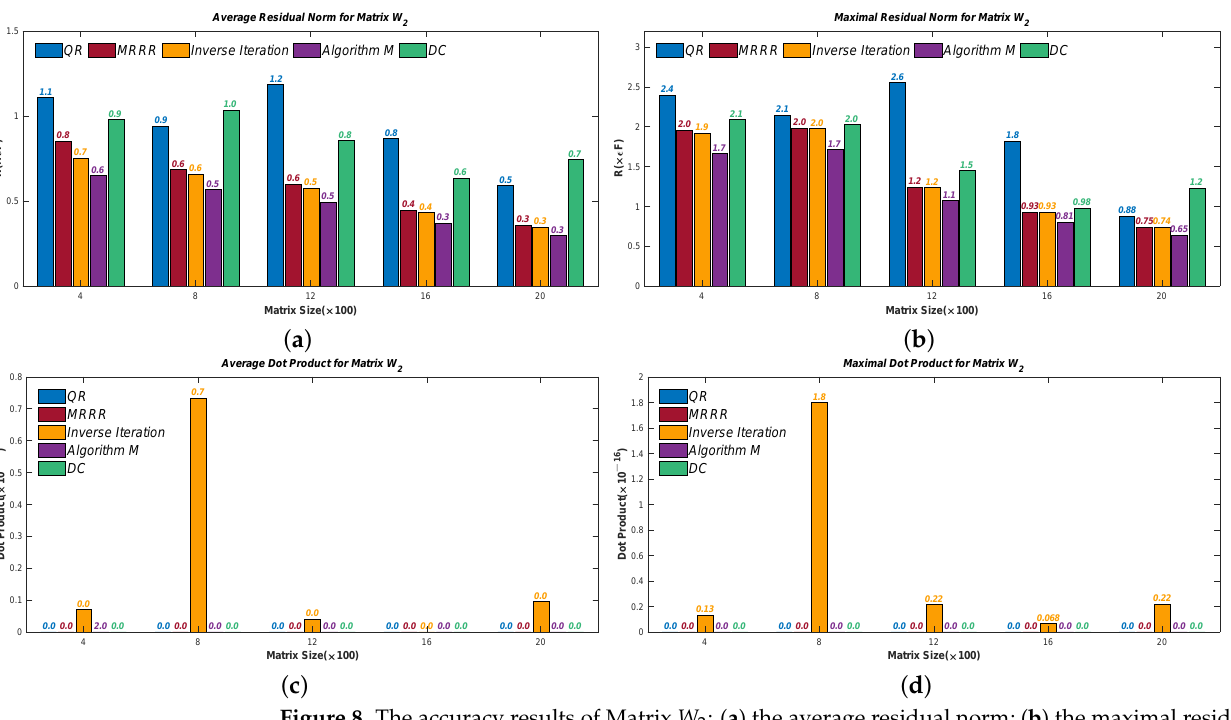
Figure 8. The accuracy results of Matrix W 2 : ( a ) the average residual norm; ( b ) the maximal residual norm; ( c ) the average dot product; ( d ) the maximal dot product.